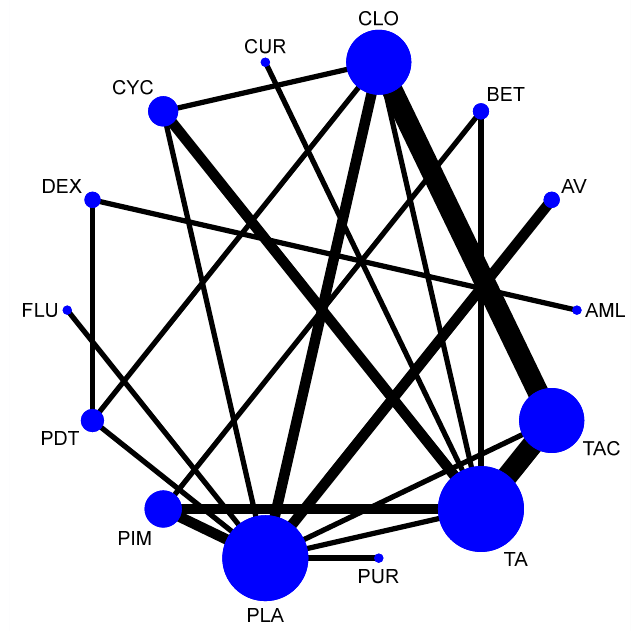
Figure 14. Network plot: Clinical Improvement (subgroup analysis). Abbreviations: AML, amlexanox paste; AV, aloe vera; CUR, curcumin gel; PDT, photodynamic therapy; PLA, placebo; PUR,